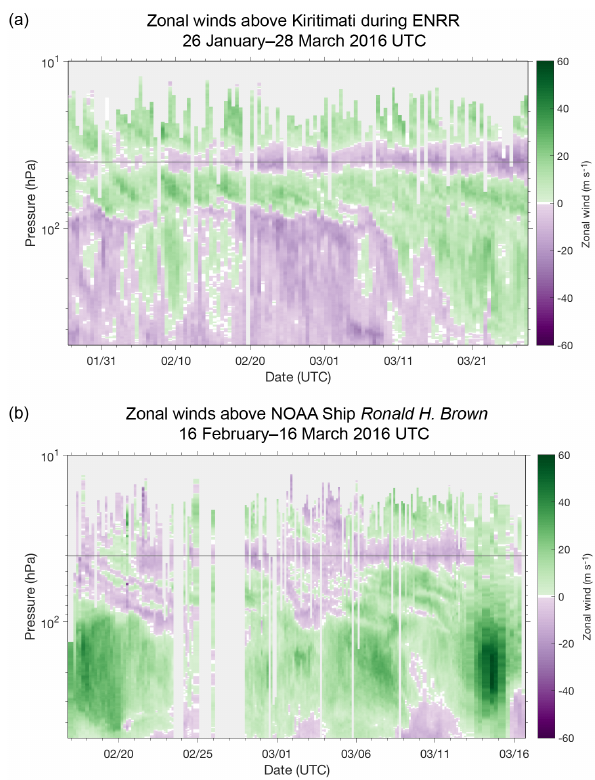
Figure 9. Zonal winds in the upper troposphere and lower strato- sphere during ENRR, as measured by radiosondes launched from (a) Kiritimati and (b) NOAA Ship Ronald H. Brown . Colors from www.ColorBrewer.org by Cynthia A. Brewer, Geography, Pennsyl- vania State